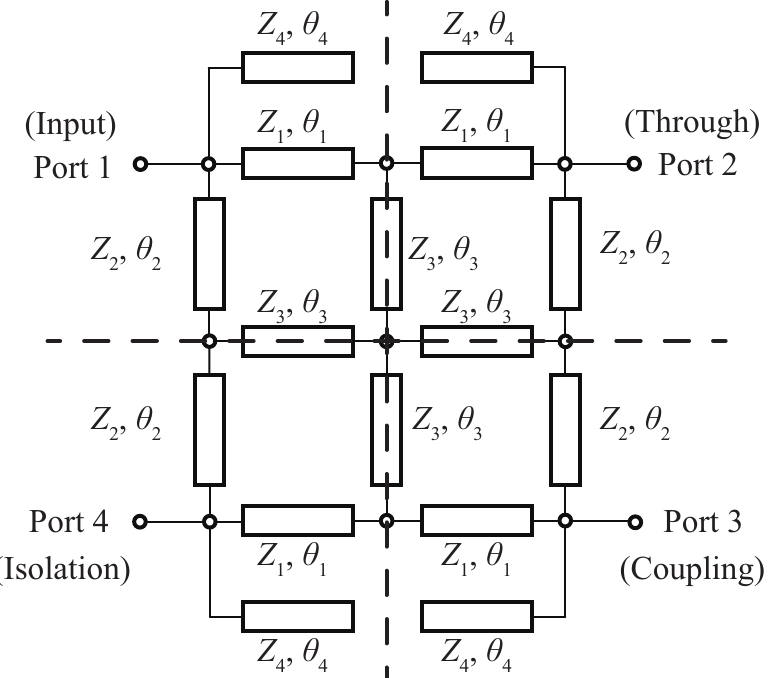
Figure 1. Schematic of proposed dual-band coupler with crossed lines and open-ended stubs. Dotted lines are planes of